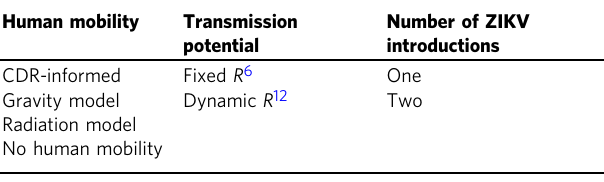
Table 1 Different model assumptions regarding the role of human mobility in facilitating pathogen spread across the country, the relationship between environmental conditions and transmission of ZIKV, and the number of times the virus was introduced into